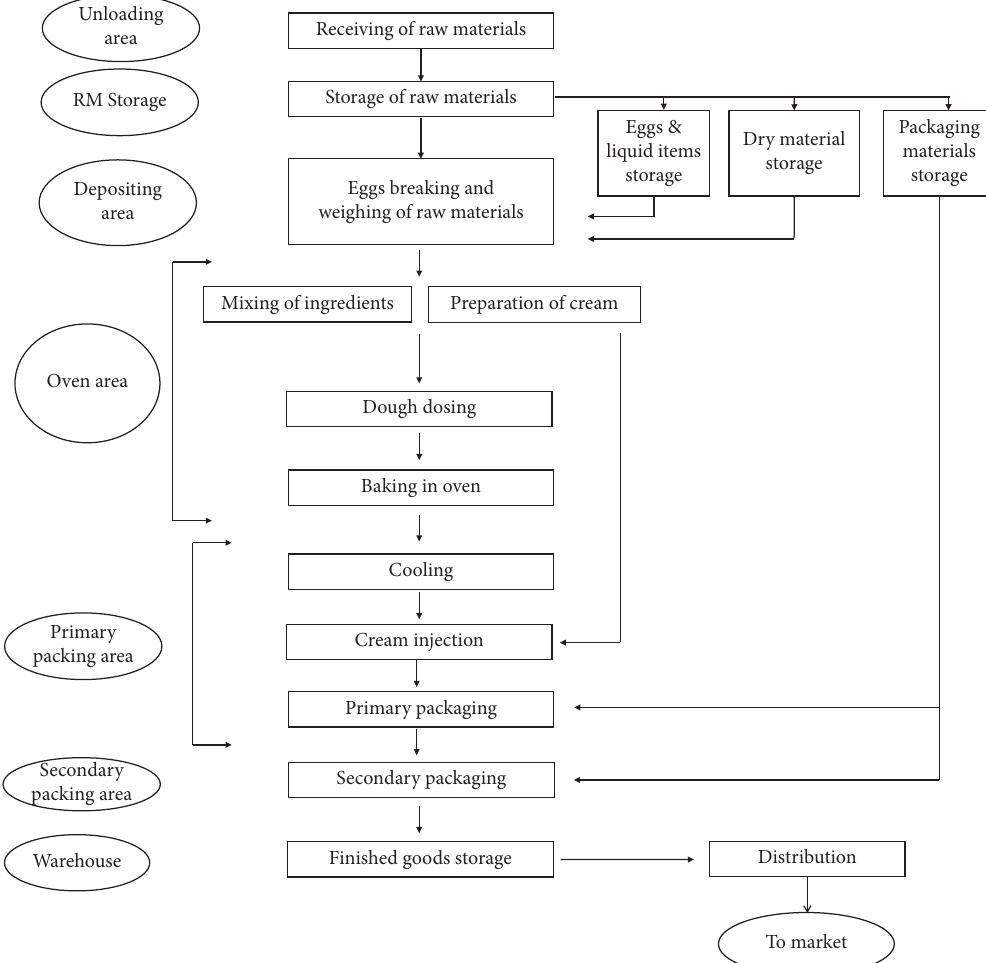
Figure 2: Complete flowchart of the cake manufacturing process. Table 2: Likelihood and consequence criteria to specify potential hazard in cake manufacturing process. Likelihood (probability)